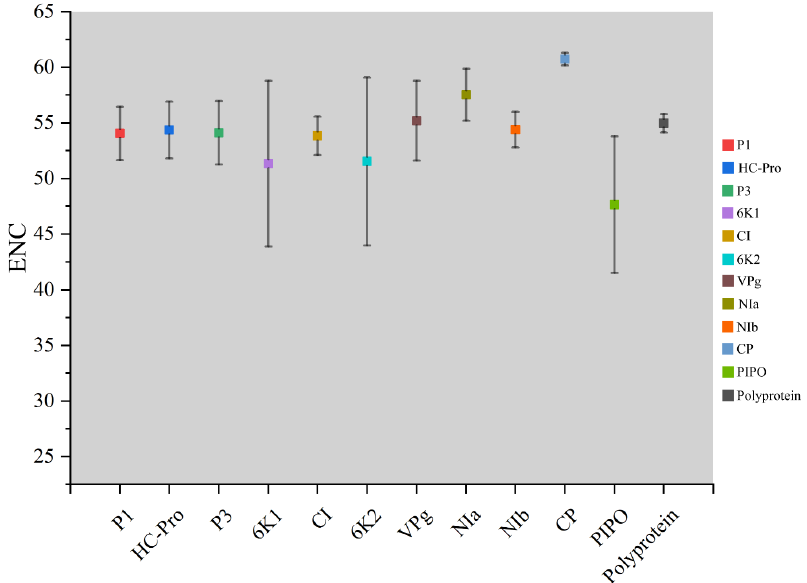
Figure 2 . Effective number of codons analysis (ENC) values for the eleven protein and complete polyprotein-coding sequences of turnip mosaic virus.